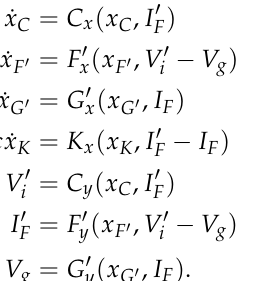
. Thus, given F (cid:48) = F (cid:48) ( x − V g ) (12). F (cid:48) , V y F i (cid:48) (cid:54) = F ) and real ( V i ) S , the virtual ( V S i